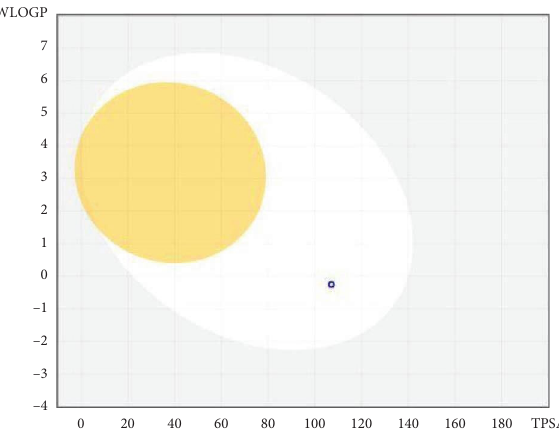
Figure 3: Boiled graph representation of C2.